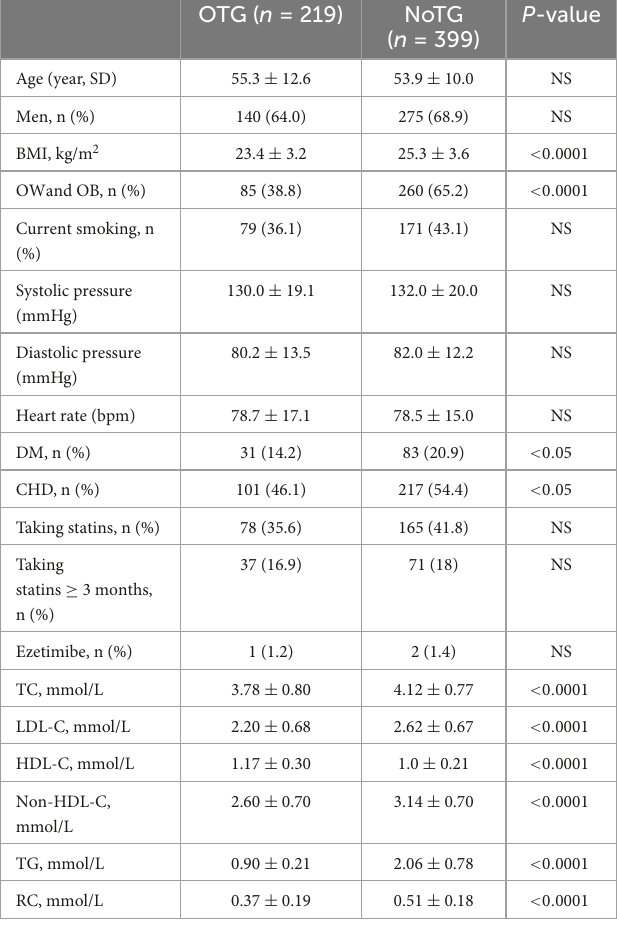
TABLE 1 Comparison of clinical features between two